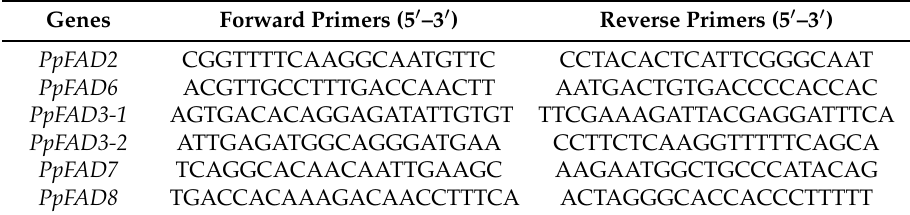
Table 1. Primers used for PpFADs expression analysis in peach